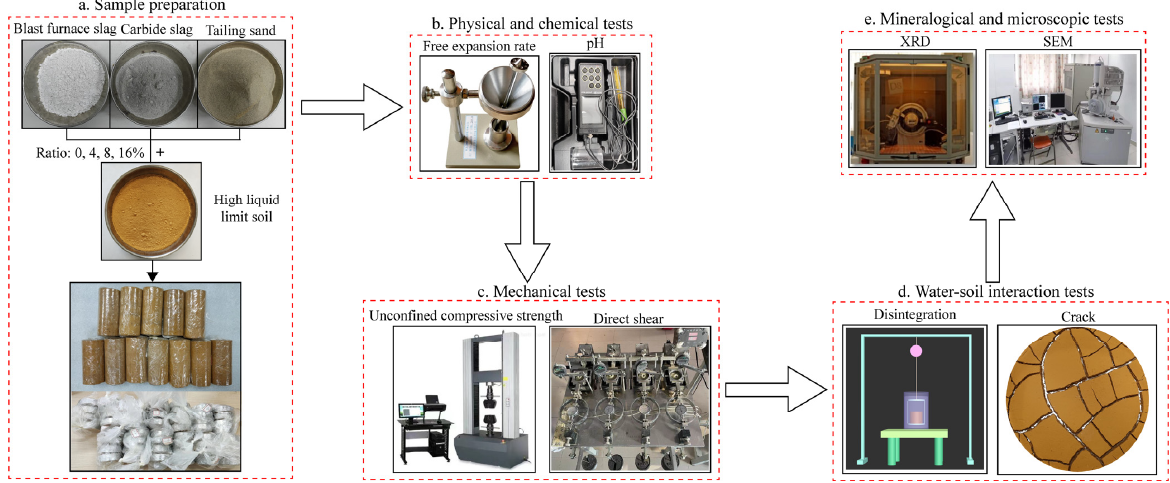
Figure 2. Schematic diagram of test flow. (a) Sample preparation (b) Physical and chemical tests (c)